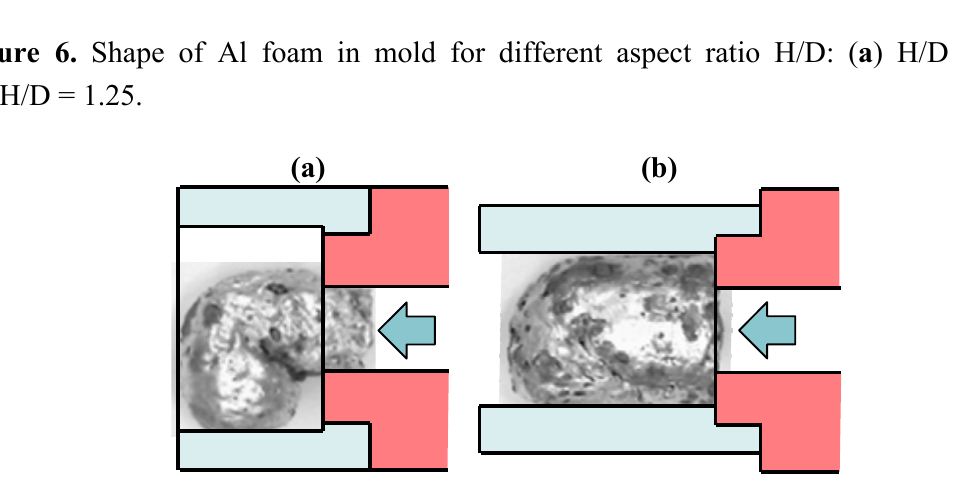
Figure 6. Shape of Al foam in mold for different aspect ratio H/D: ( a ) H/D = 0.45;